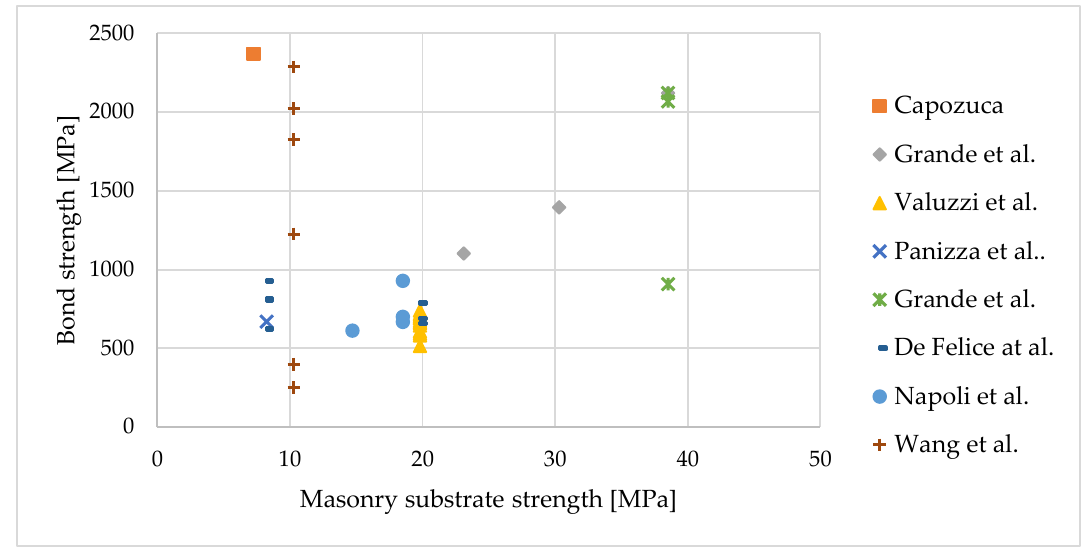
Figure 4. Review of bond strength test results concerning masonry substrate [7,9,19,21–25].